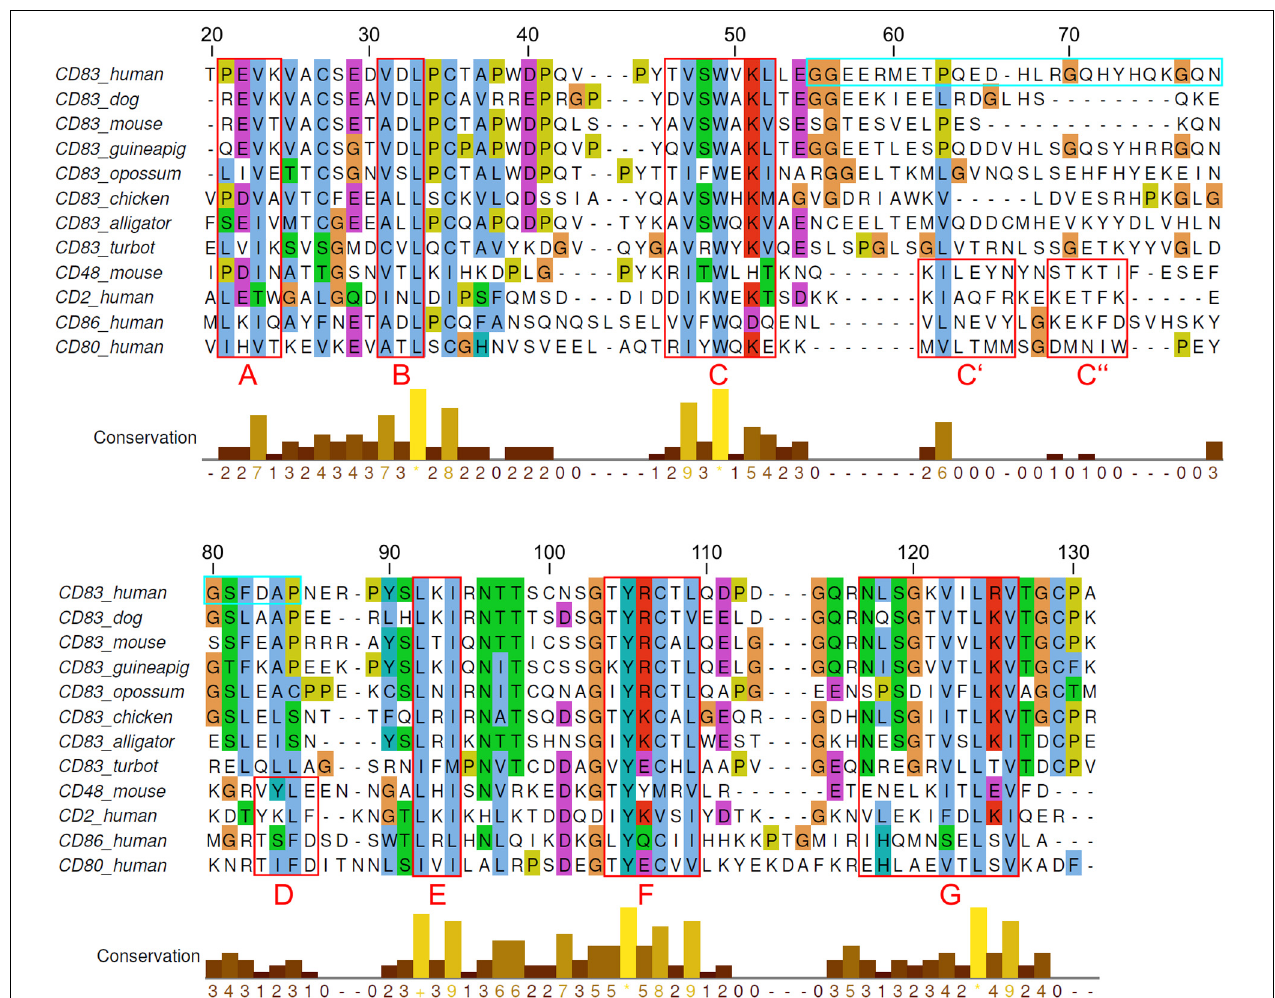
FIGURE 2 | Multiple sequence alignment of CD83 orthologs and paralogs. The alignment includes eight CD83 orthologs from different species as well as four paralogous Ig-domains of high structural similarity. The sequence numbering of hCD83 is given on top of the alignment. Characteristic β -strands of Ig-domains are indicated by red boxes and labeled. A cyan box marks the sequence stretch that is not visible in the hCD83 crystal structure. Sequences were retrieved from UniProt and NCBI and the alignment was performed using ClustalOmega. The alignment of the paralogs was further adjusted using the structural information from PDB entries 5mixA, 2ptvA, 1qa9A, 1ncnA, 1i8lA. Visualization of the alignment was done with Jalview using the “Clustal” coloring scheme for residue